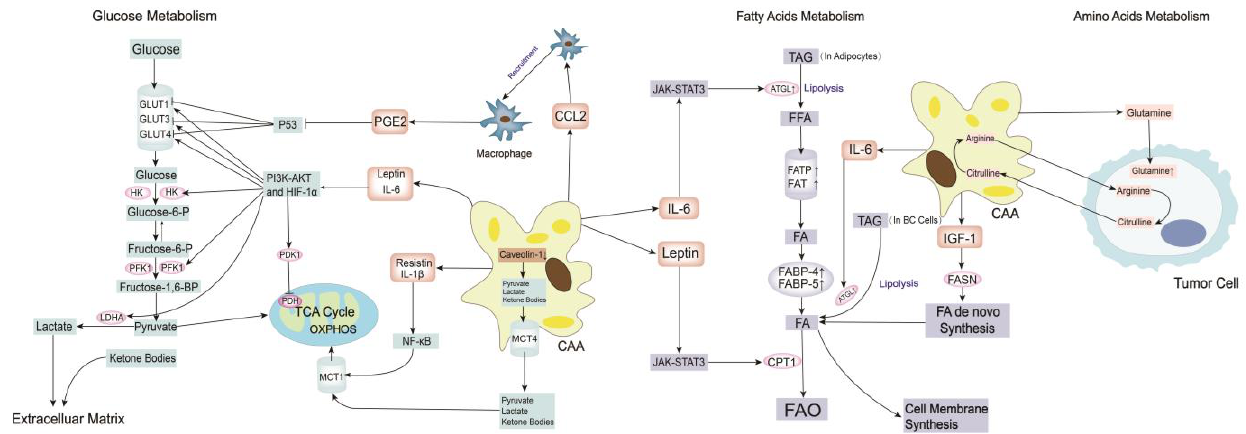
Figure 3. CAAs remodel BC metabolism. CAAs promote the expression of GLUT and the glycolysis rate-limiting enzymes HK and PFK1 to transport more glucose into BC cells and increase glycolysis in BC cells. CAAs promote the expression of LDH and PDK1 to increase lactate production and inhibit the TCA cycle in BC cells. CAAs promote the expression of MCT1 in BC cells to increase the uptake of pyruvate, lactate and ketone bodies, which are material for OXPHOS. Upregulated MCT4 in CAAs facilitates the efflux of pyruvate, lactate, and ketone bodies that are transported into adjacent BC cells as material of OXPHOS. CAAs promote the expression of ATGL in adipocytes and BC cells to increase lipolysis and produce more FFAs, which are energy resources and substrates for cell membrane synthesis. CAAs promote the expression of FAT, FATP, FABP4 and FABP5 to transport FFAs into BC cells. CAAs promote the expression of CPT1 to increase FAO to provide more energy. CAAs provide more glutamine for adjacent BC cells. CAAs take up citrulline in the extracellular matrix and convert it to arginine, which is consumed and decomposed to produce citrulline in tumor cells again. Abbreviations: BC, breast cancer; CAAs, cancer-associated adipocytes; IL-6, interleukin-6; IL-1 β , interleukin-1 beta; TME, tumor environment; GLUT, glucose transporter; glucose-6-P, glucose-6-phosphate; fructose-6-P, fructose-6-phospahte; fructose-1,6-BP, fructose-1,6-biphosphate; HIF1 α , hypoxia-inducible factor 1 alpha; HK, hexokinase; PFK, phosphofructokinase; LDHA, lactose dehydrogenase A; PI3K, phosphatidylinositide 3-kinase; AKT, protein kinase B ; PDH, pyruvate dehydrogenase; PDK, pyruvate dehydrogenase kinase; MCT, monocarboxylate transport protein; TNF- α , tumor necrosis factor alpha; PGE2, prostaglandin E2; NF- κ B, nuclear factor-kappa B; TCA, tricarboxylic acid cycle; OXPHOS, oxidative phosphorylation; LIF, leukemia inhibitory factor; TAG, triacylglycerol; ATGL, adipose triglyceride lipase; FFA, free fatty acids; FATP, fatty acid transporter protein; FAT, fatty acid translocase; FABP, fatty acids binding protein; CPT1, carnitine palmitoyl transferase 1; FAO, fatty acid oxidation ; FASN, fatty acid synthase; JAK, janus tyrosine kinase; STAT, signal transducer and activator of transcription.